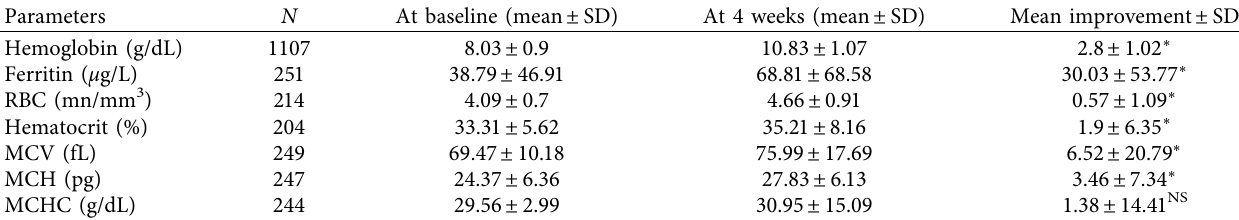
Table 3: Comparing hematological parameters before and after administration of ferric carboxymaltose in pregnant women. Parameters